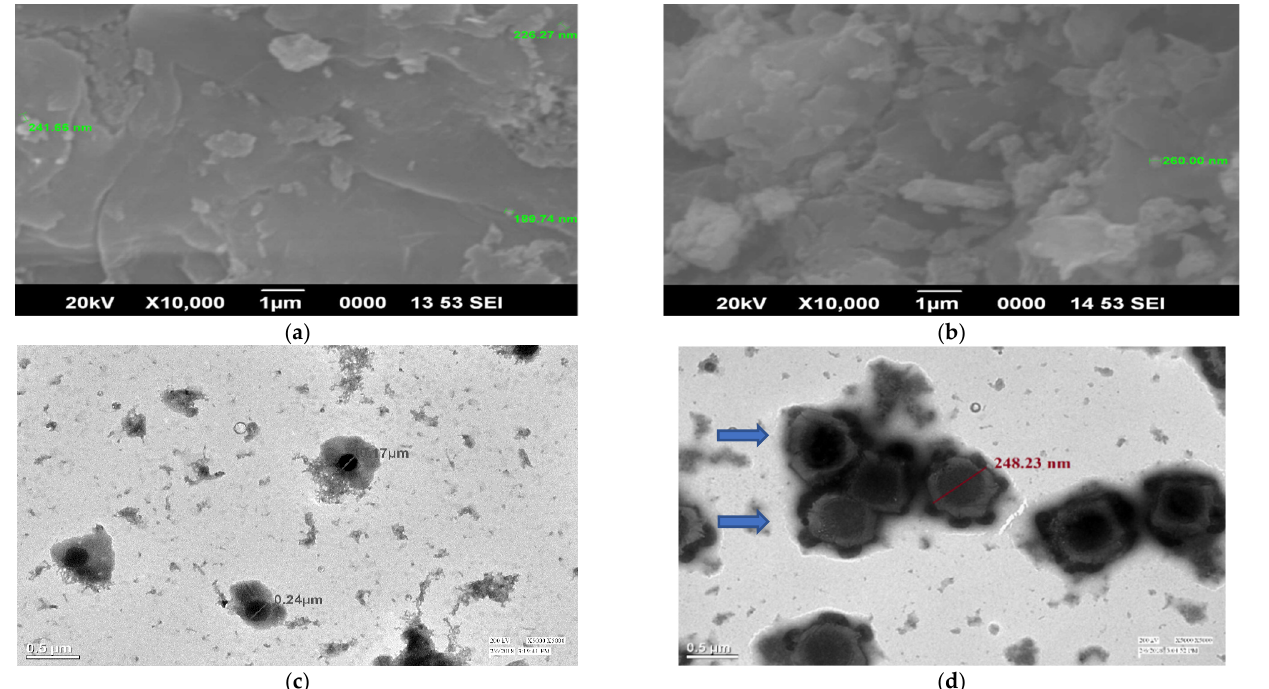
Figure 7. Electron microscopy of blank and loaded nanoparticles. SEM micrographs of ( a ) blank CSCRG NPs and ( b ) mancozeb-loaded CSCRG NPs. TEM micrographs of ( c ) blank CSCRG NPs and ( d ) mancozeb-loaded CSCRG NPs.